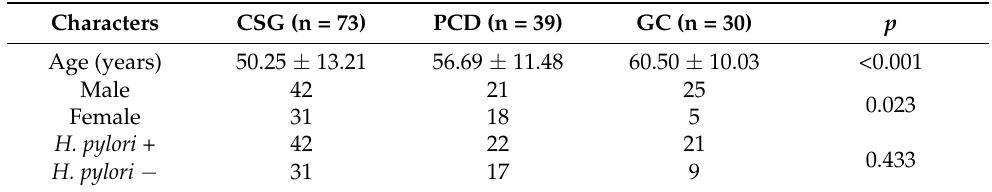
Table 2. Profiles of the involved